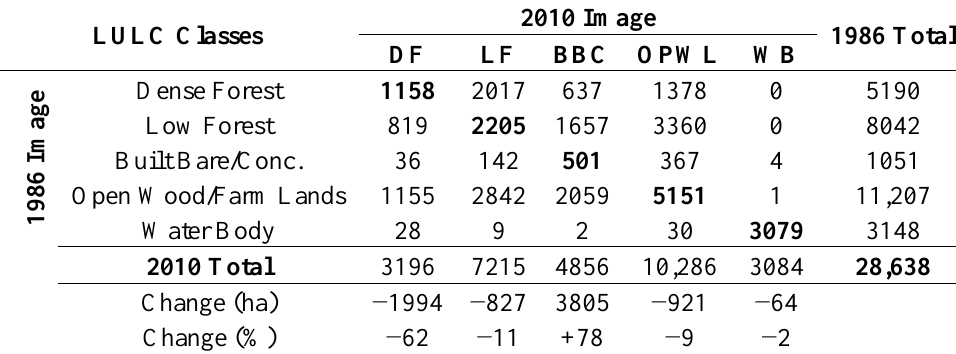
Table 4. Land use class transition matrix from 1986 to 2010.